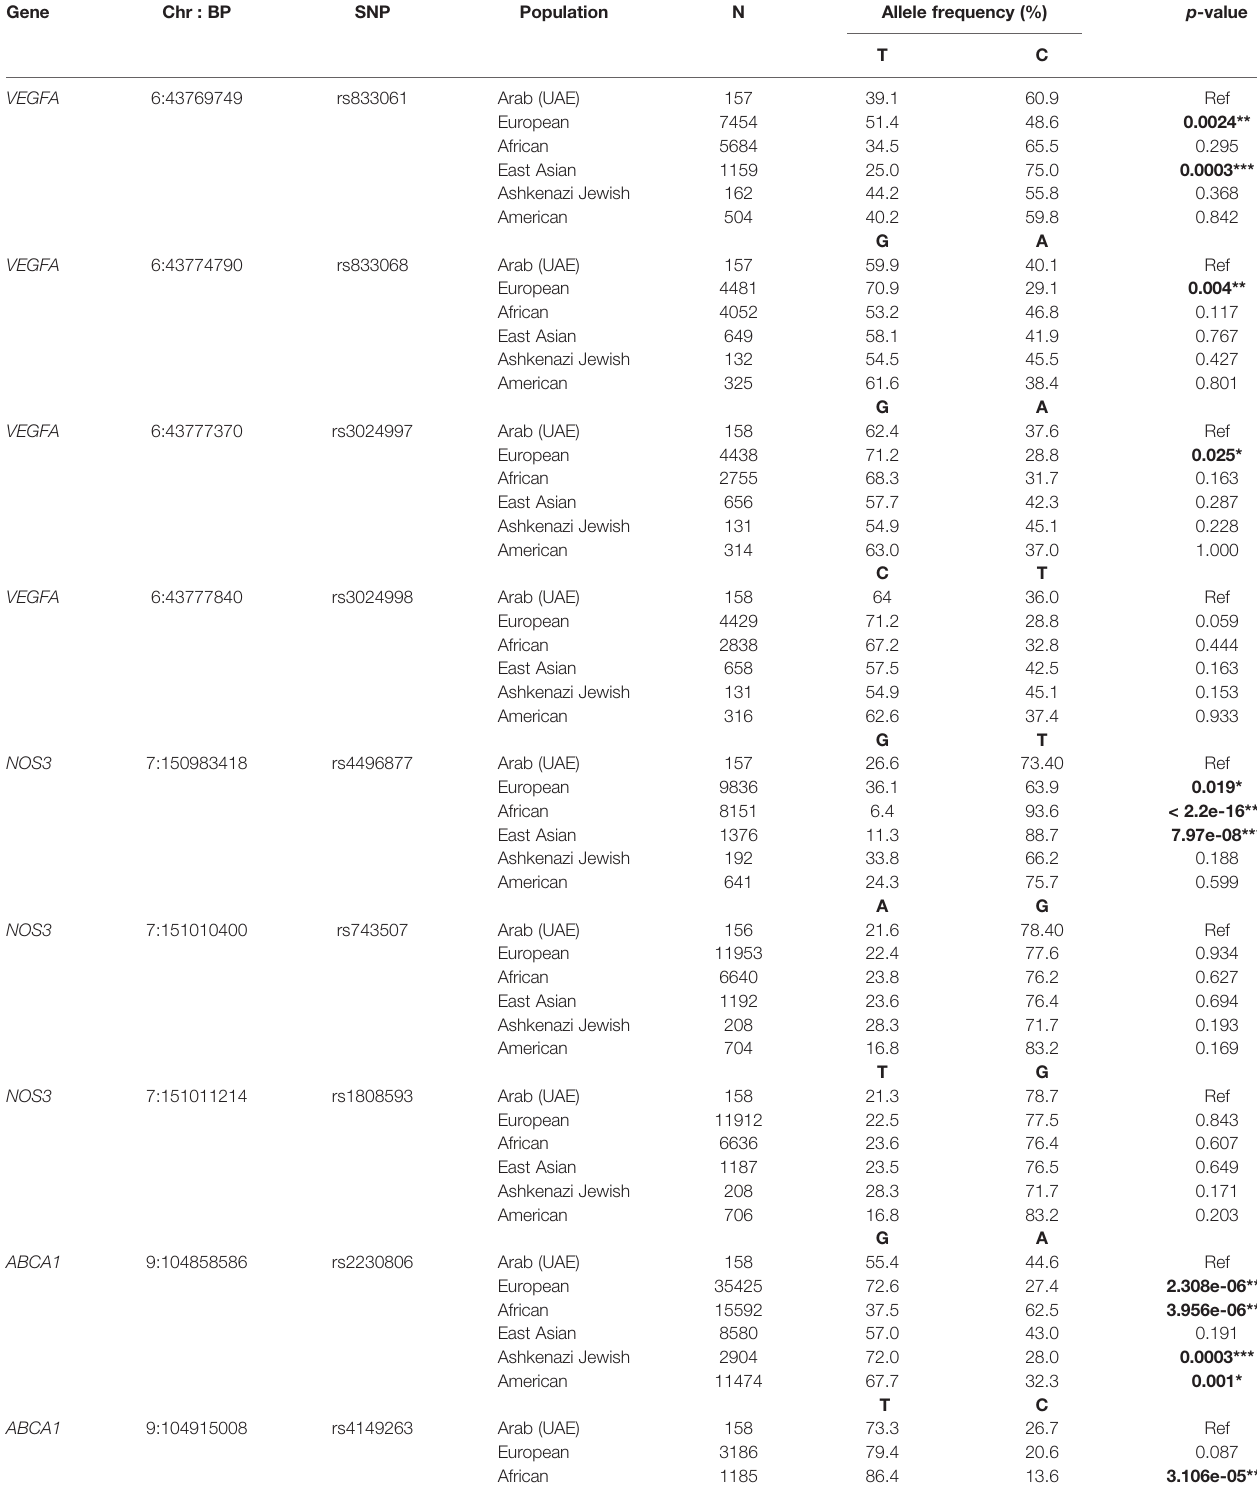
TABLE 4 | Allele frequencies of SNPs most strongly associated with various complications in our population (Arab) and other ethnicities. Gene Chr : BP SNP Population N Allele frequency (%) p -value